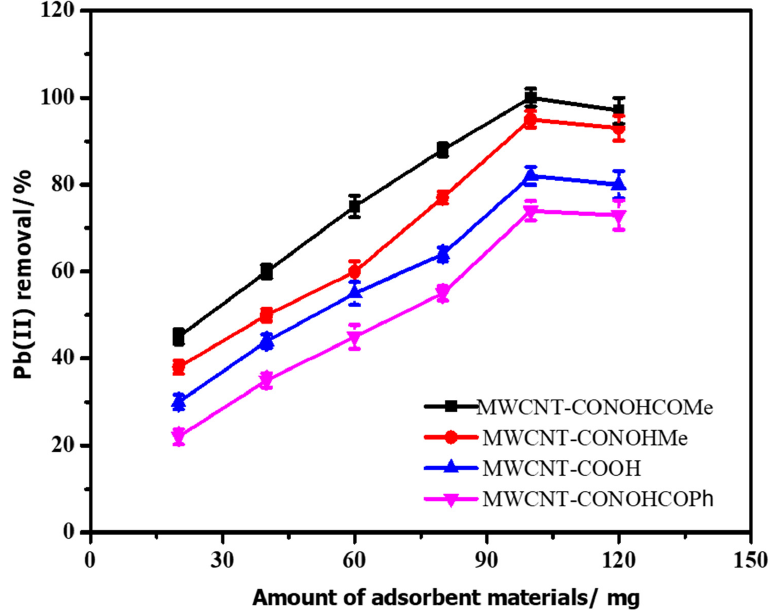
Figure 10. The effect of adsorbent material doses on Pb 2+ removal % using a pH of 8.0 for 50 min at 30 °C.